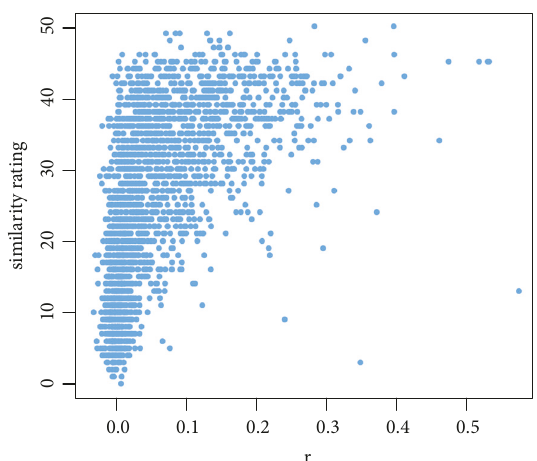
Figure 1: Similarity rating in the MEN dataset as a function of the correlation 𝑟 between the row vectors in S of the words in the test